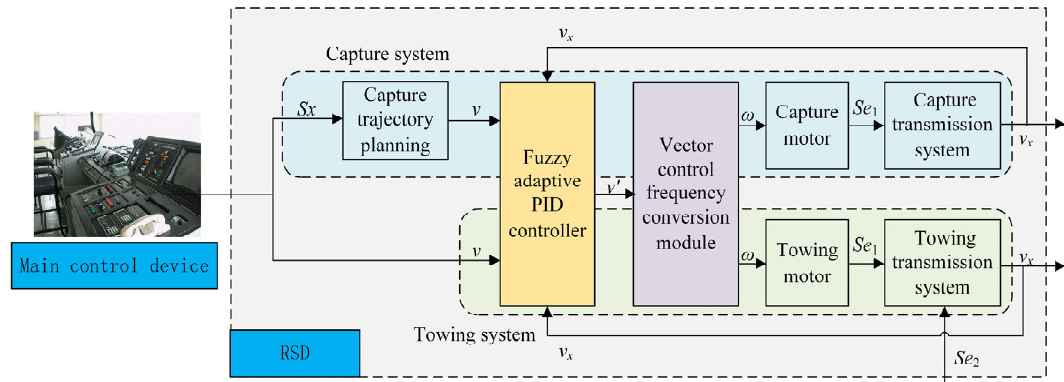
Figure 6. The control system structure.